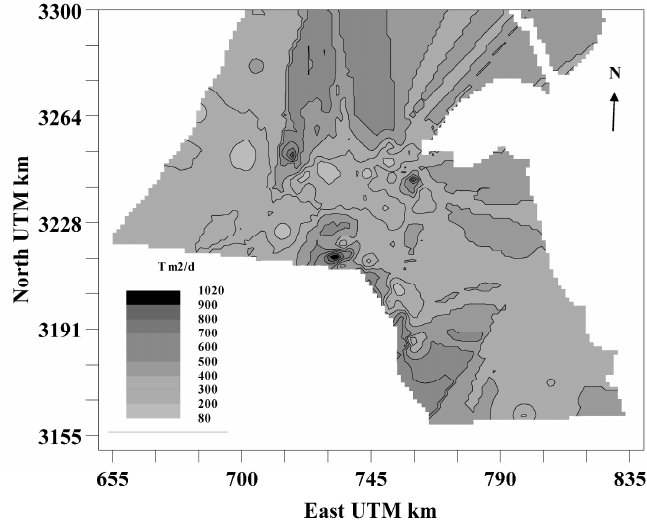
Figure 12. Estimated transmissivity distribution of the Kg aquifer.